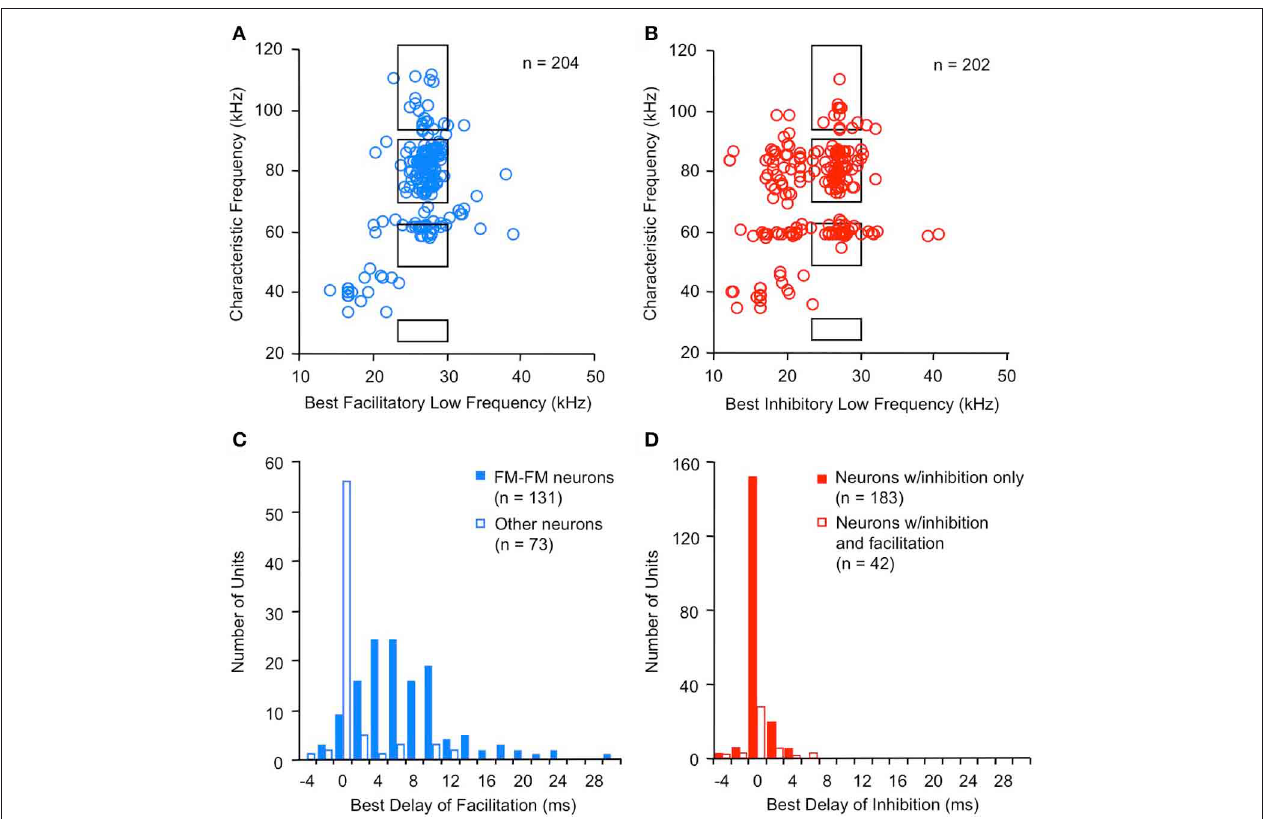
neurons but tightly distributed around 0ms delay for other types of facilitated neurons. Delay tuning of combination-sensitive inhibition (D) was similar for neurons showing only inhibition and for those facilitated neurons showing early inhibition. Data from Portfors and Wenstrup (1999); Leroy and Wenstrup (2000); Nataraj and Wenstrup (2005,